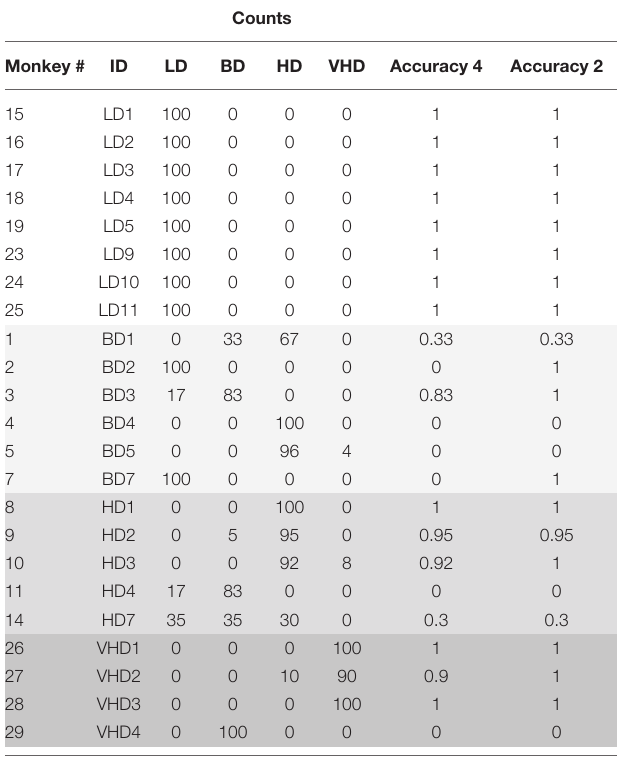
TABLE 3 | One hundred model simulations using parameters estimated from each monkey’s